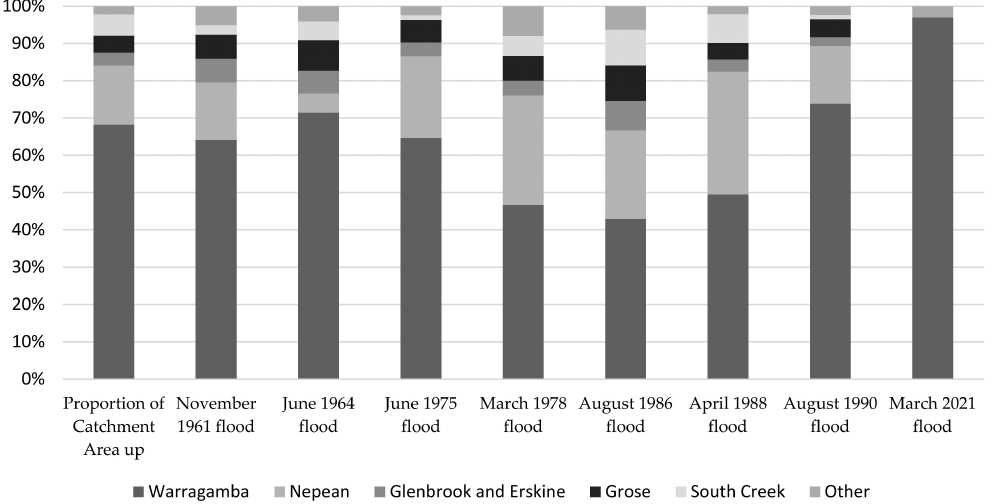
Figure 4. The overall sub-catchment contributions to flooding events at Windsor since 1960.